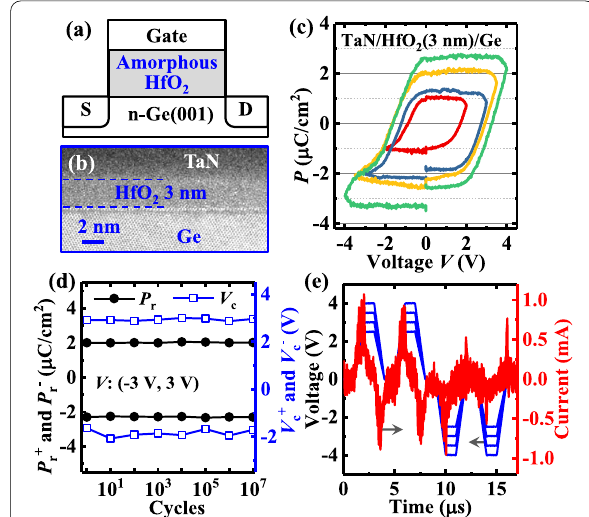
Fig. 1 a Schematic of the NVFET with amorphous HfO 2 gate insulator. b HRTEM image shows the 3-nm-thick amorphous HfO 2 . c Measured P–V curves for TaN/HfO 2 /Ge capacitor. d P r and V c vs. the number of sweeping cycles for amorphous HfO 2 capacitors. e PUND test of HfO 2 capacitor exhibiting the switching current component by isolating the non-switching